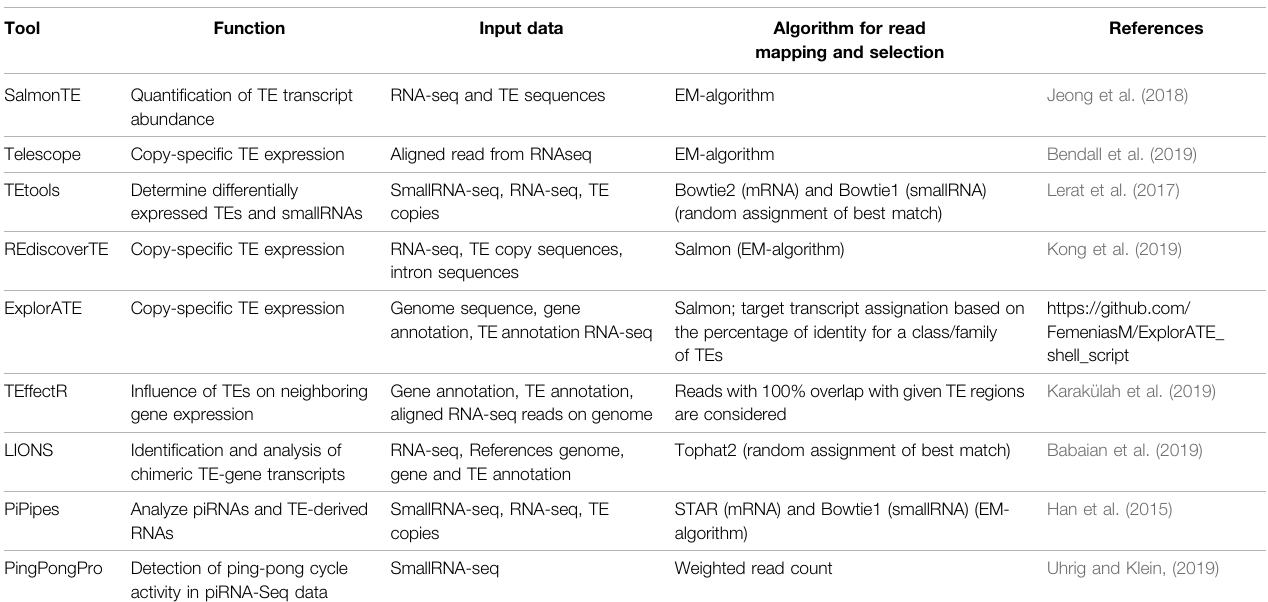
TABLE 1 | Recent tools for transcription and small RNA analysis.